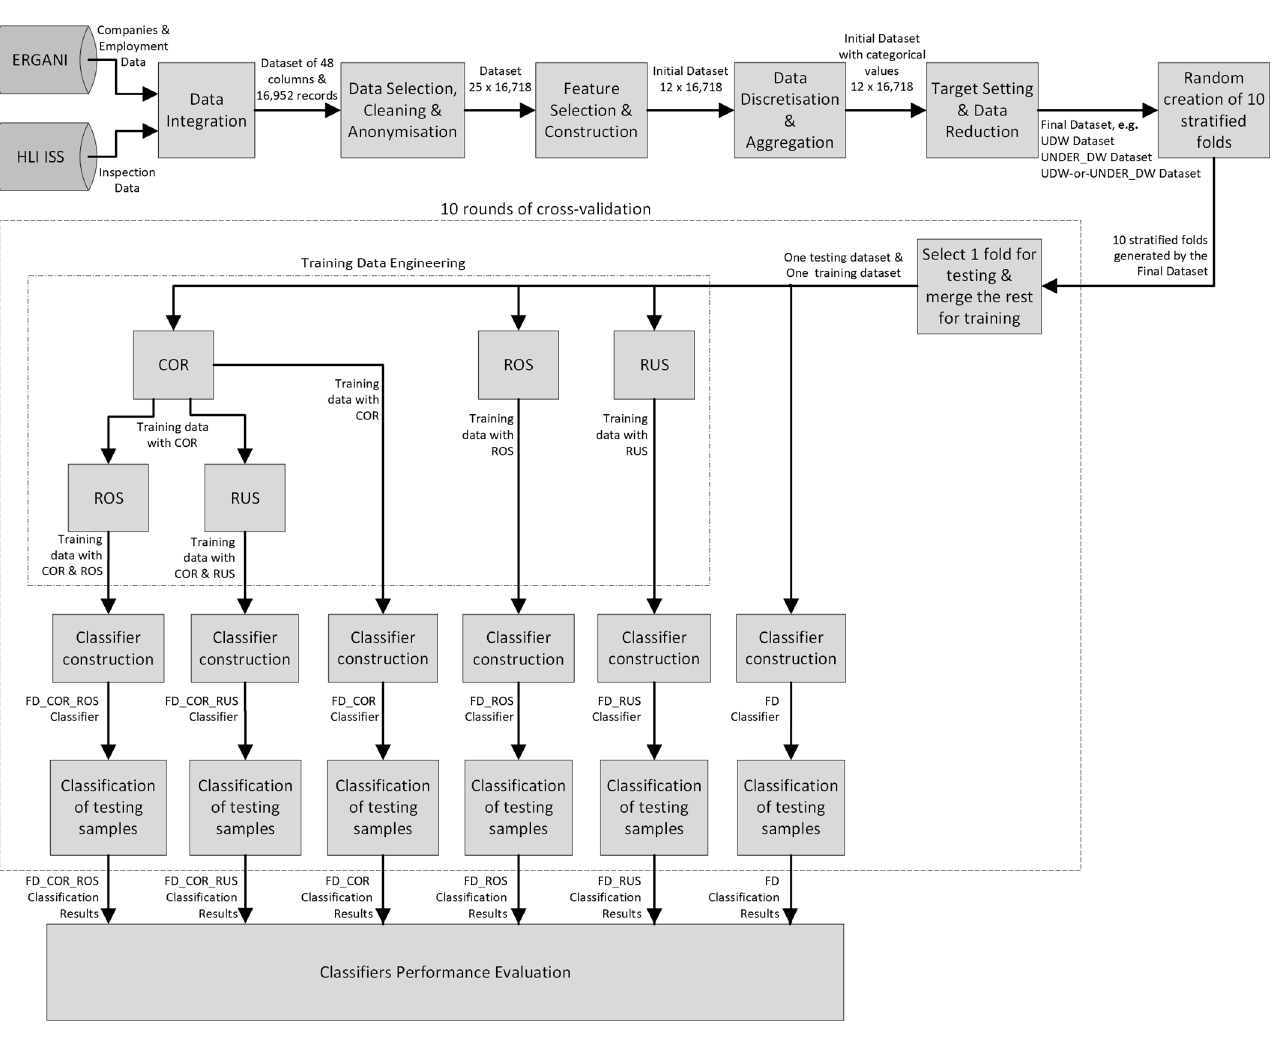
Figure 3. Methodology steps to create the initial dataset and then, after target setting, to construct a final dataset, e.g., the UDW dataset. From the same final dataset and using the same AC algorithm, six models are produced, based on the different training data class distributions, and evaluated.